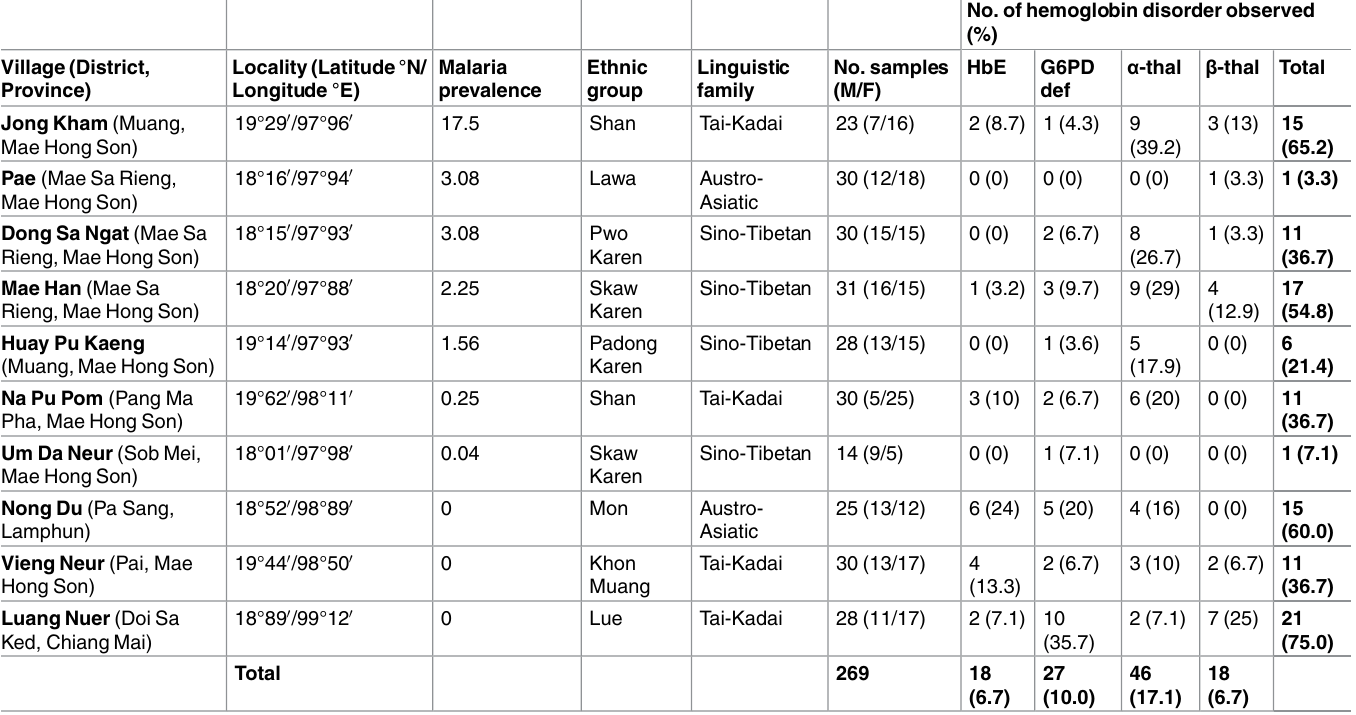
Table 1. Villagesstudy, rankedby highand low periodprevalence of malariabetween2007 through2012 (selectioncriteriafor study),from details on study participants, theirlocalities,the percentages of malariareported,ethnicgroup, linguisticfamilies,numberof sample in each groups,the number(and percentages)of hemoglobin